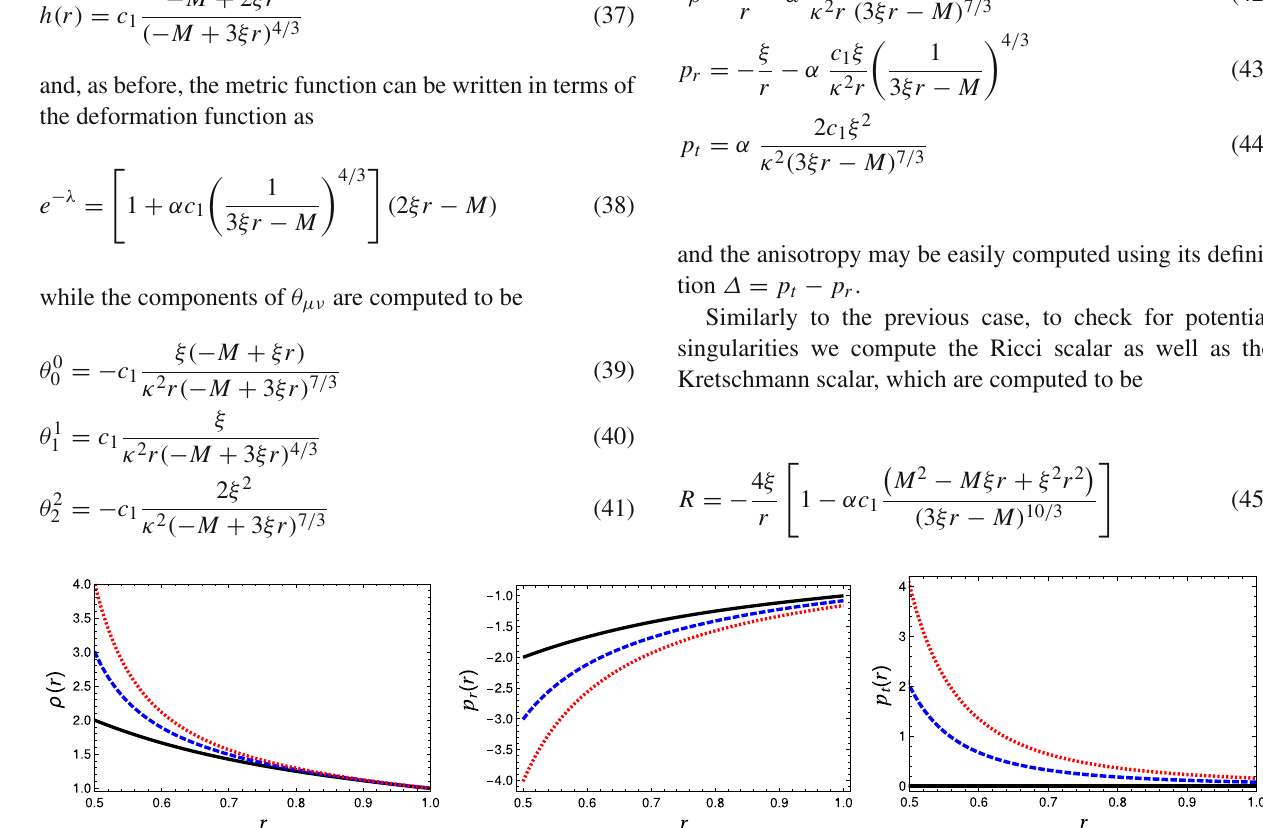
different values of the parameter α . Shown are: (i) α = 0 (solid black line), (ii) α = 0 . 2 (dashed blue line) and, (iii) α = 0 . 4 (dotted red line). The other two parameters have been taken equal to unity, M = ξ =